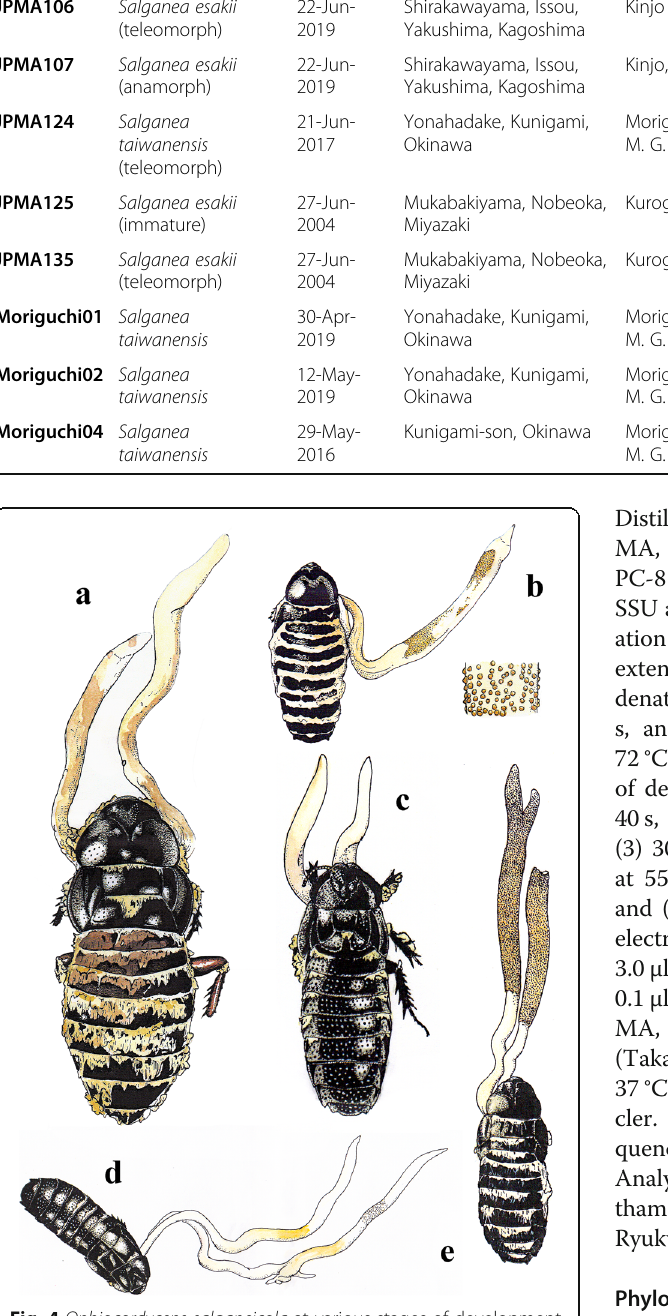
Fig. 4 Ophiocordyceps salganeicola at various stages of development (del. M. G. Moriguchi). a Sexual morph of O. salganeicola growing on Salganea esakii collected in Miyazaki, 22 Jun. 2005. b Sexual morph on S. esakii collected in Yakushima, 17 Jun. 2017. with a close-up illustration of perithecia. c Early-stage specimen. d Mid-stage specimen (Mori04; see Tables 1 and 2) collected in Katsuu-dake, Nago-shi, Okinawa, 23 Apr. 2016. e Mature specimen from